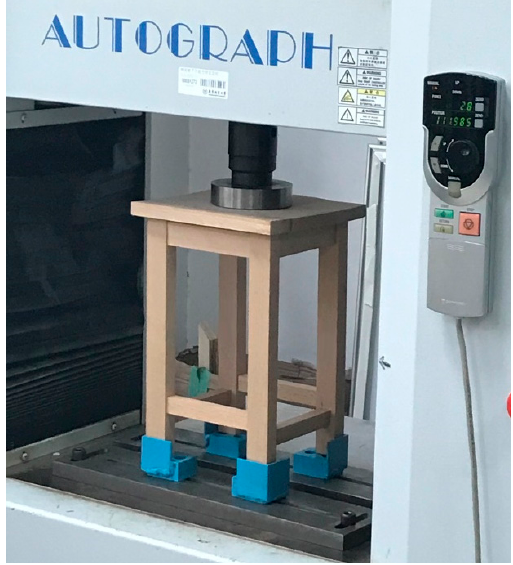
Figure 6. Setup for measuring loading capacity of chair.